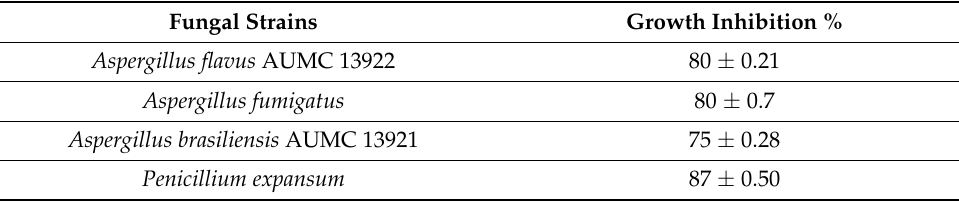
Table 4. Antifungal potential of kefir extract (100 mg/mL) against selected pathogenic fungal